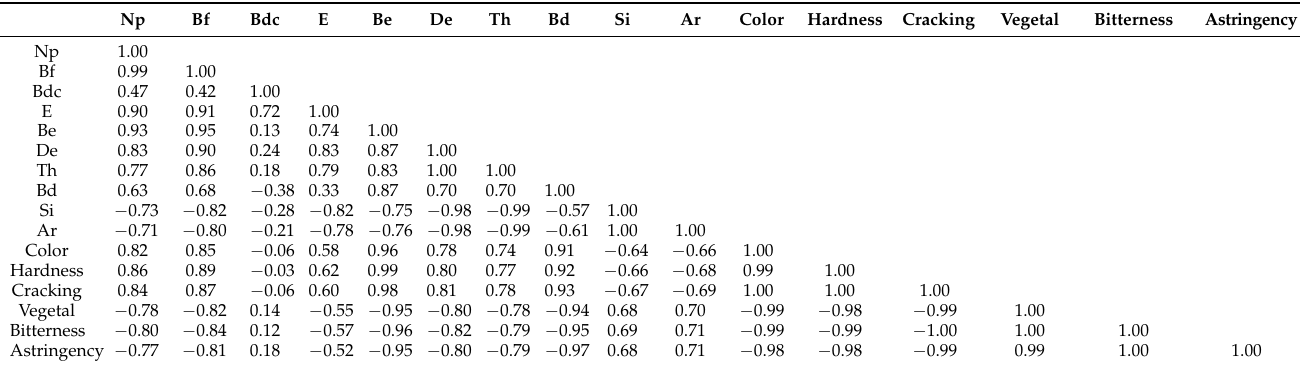
Table 6. Correlation matrix between instrumental texture parameters and sensory attributes at different maturity stages (MS) established by DigiEye ®